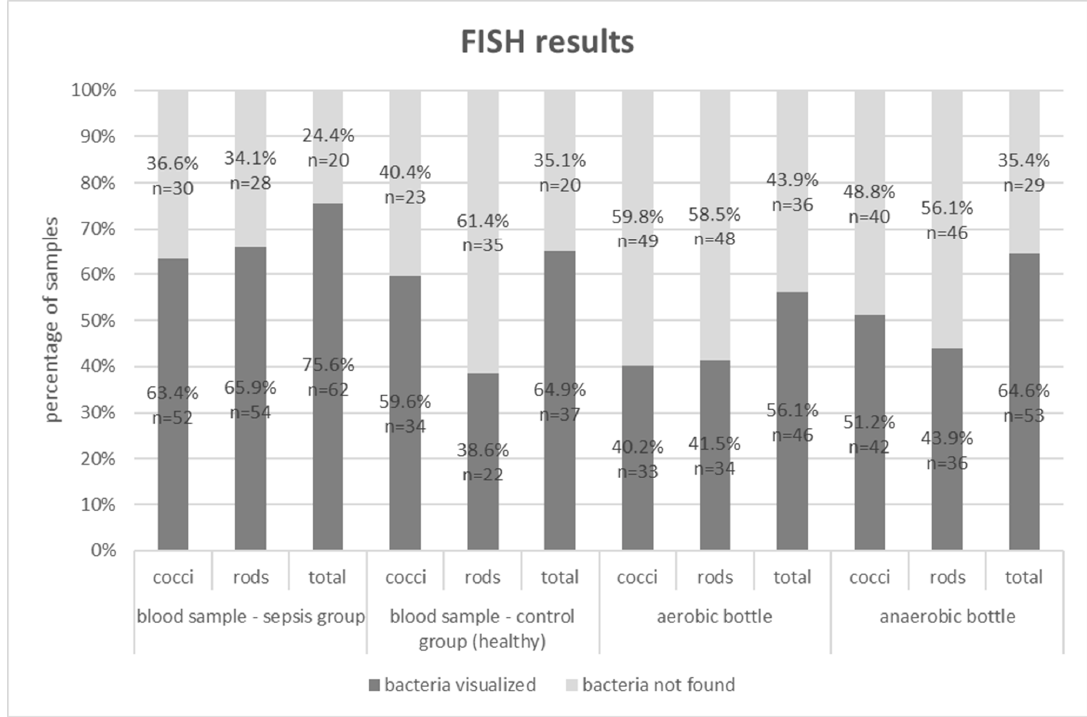
Figure 2. FISH results for blood samples, aerobic and anaerobic bottles in the group of patients with sepsis and for blood samples in the control group; ( n )—absolute values of visualized